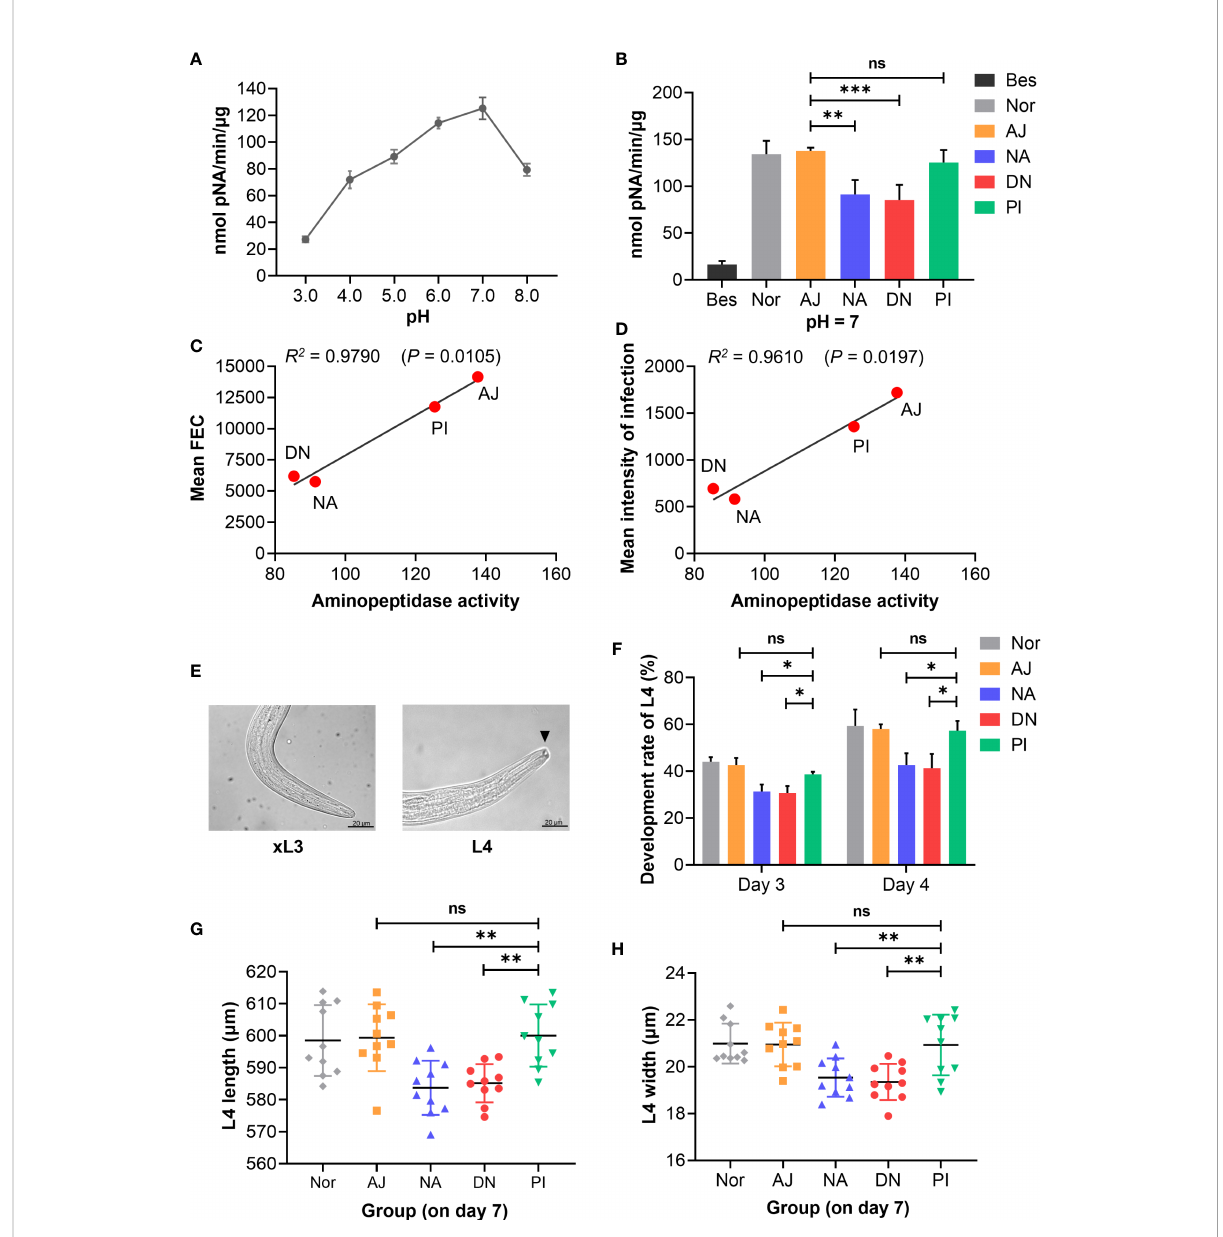
FIGURE 8 Anti-H11 IgG antibodies from immunoprotected goats inhibit intestinal aminopeptidase activity and Haemonchus contortus development. IgG antibody inhibition assays were assessed by inhibiting intestinal aminopeptidase activity and H. contortus development in vitro. Five IgG antibodies: one was puri fi ed from the normal pre-immunisation sera; four were puri fi ed from pooled sera samples (collected on day 42 of the immunisation trial, cf. Figure 4A) from individual animal groups (AJ, NA, DN or PI). (A) Determination of intestinal aminopeptidase activity at pH 3.0 to 8.0 to assess the optimal pH of aminopeptidase. Intestinal homogenate from adult H. contortus was incubated with 0.2 mM L-leucine-p- nitroanilide (L-Leu-pNA) substrate. Enzyme activity was detected at 405 nm and expressed as nanomole of pNA/min/µg. (B) Inhibition assays of intestinal aminopeptidase activity were performed in the optimal pH by pre-incubation with each group of IgG antibodies (1 µg/µL; 5 m L aliquots) and followed by incubation with L-Leu-pNA substrate. The inhibitor sensitivity assay was carried out by incubation with 10 m M bestatin (Bes). (C, D) Correlations of aminopeptidase activity inhibition by each groups of IgG antibodies (AJ, NA, DN or PI) with mean faecal egg count (FEC, C ) and mean intensity of infection (D) in passive immunisation trials. (E, F) Exsheathed L3s (xL3s) were cultured in 200 m L of sterile Luria Bertani (LB) medium and then fi ve groups of IgG antibodies (1 µg/µL; 50 m L aliquots) were added to the culture media, respectively. Developmental rate (%) of L4 ( n = 50) was assessed on day 3 and day 4 (F) by examining the presence of a buccal capsule ( E ; arrowhead; Scale bars = 20 µm). (G, H) On day 7 of the co-culture with indicated fi ve groups of IgG antibodies, body length (G) and width (H) of L4 ( n = 10) were measured (µm). Experiments were independently repeated three times in (A, B, F, G, H). Data show as mean ± SEM in (A, B, F) or mean ± SD in (G , H) , and analyse by one-way ANOVA, * p < 0.05, ** p < 0.01, *** p < 0.001 and ns (not signi fi